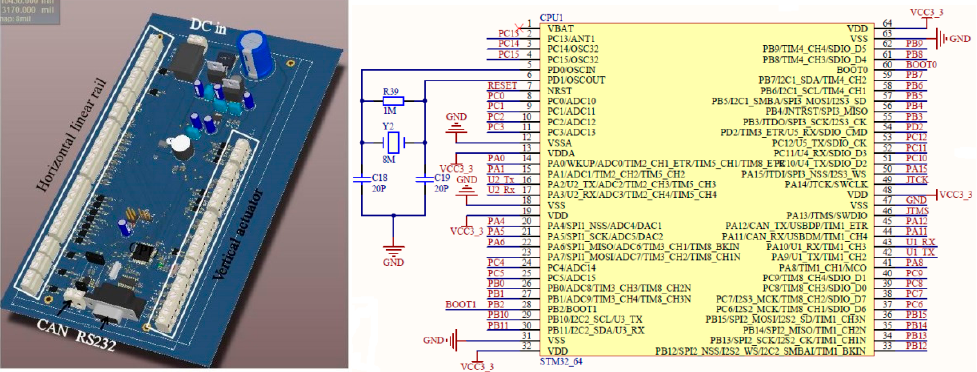
Figure 6. Central controller sketch.